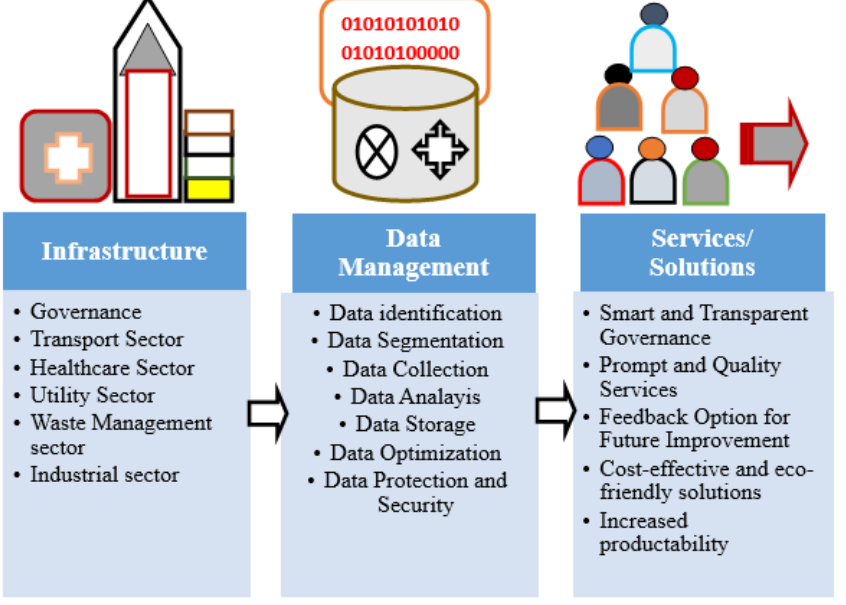
Figure 13. Proposed smart city management technique.